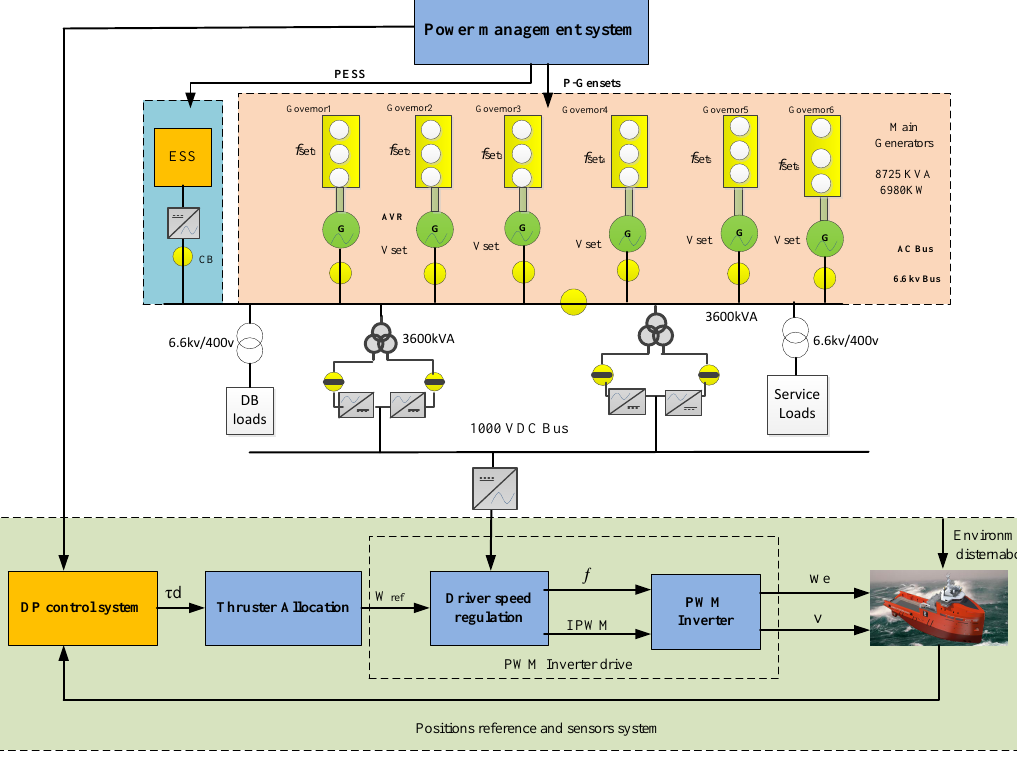
Figure 3. The relationship schematic diagram between the PMS and DP control system.